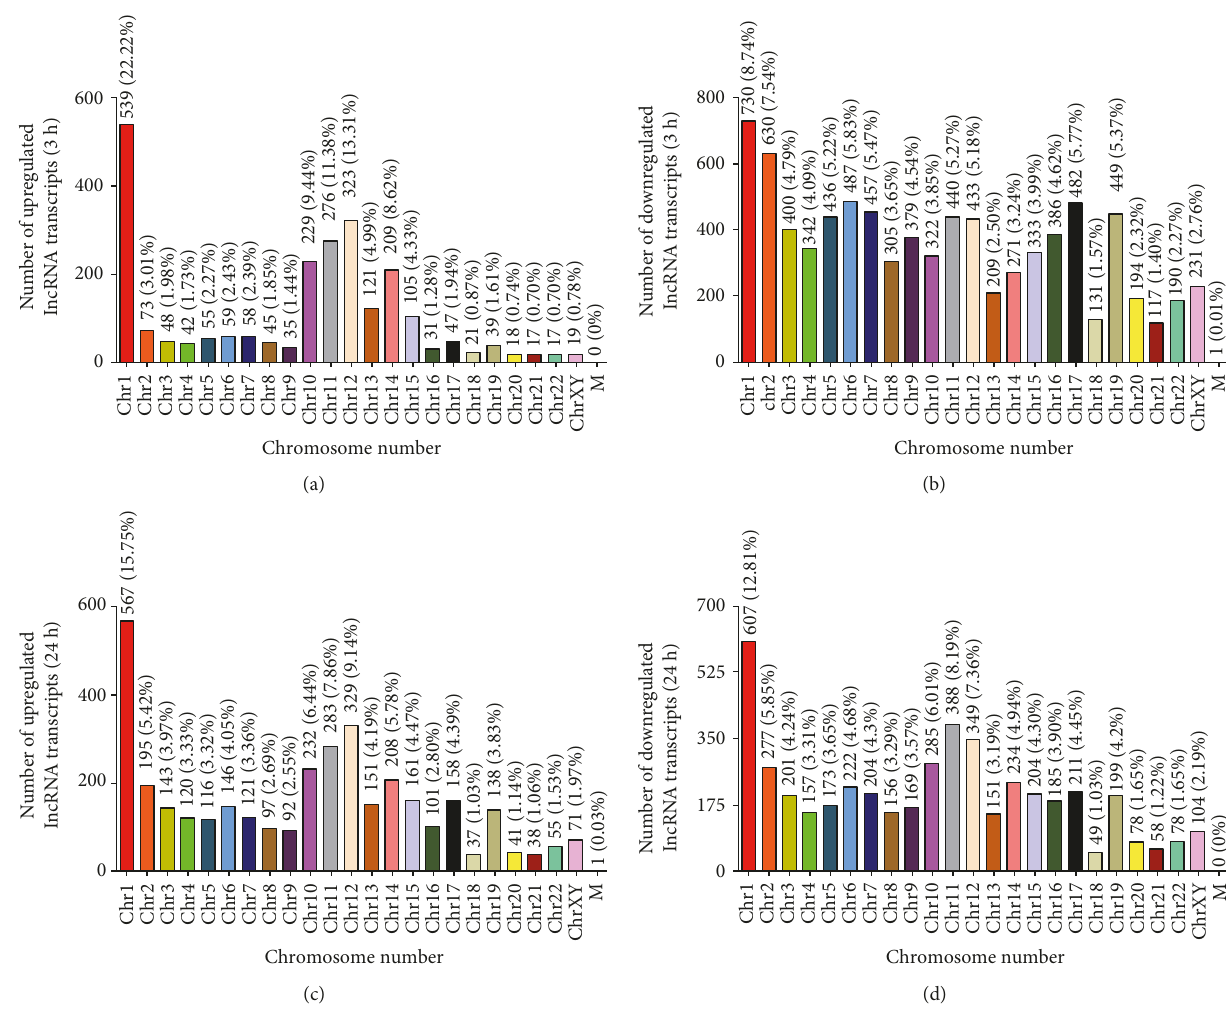
Figure 3: Chromosome-wise distribution of di ff erentially expressed lncRNA transcripts in HMECs after LPS treatment. (a) Upregulated transcripts after 3 h. (b) Downregulated transcripts after 3 h. (c) Upregulated transcripts after 24 h. (d) Downregulated transcripts after